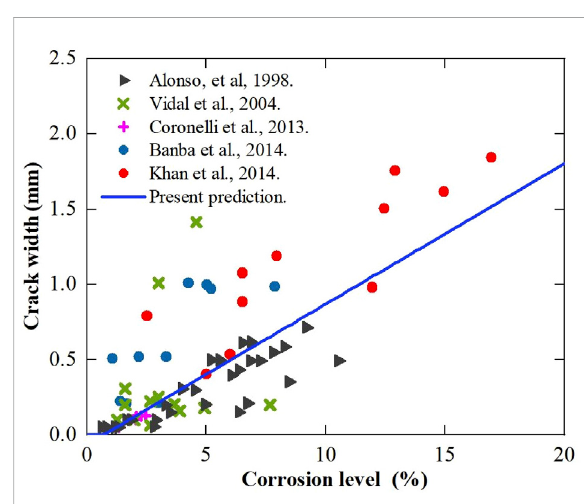
FIGURE 5 Predicted crack width on the concrete surface versus rebar corrosion level, compared with experimental data available from various